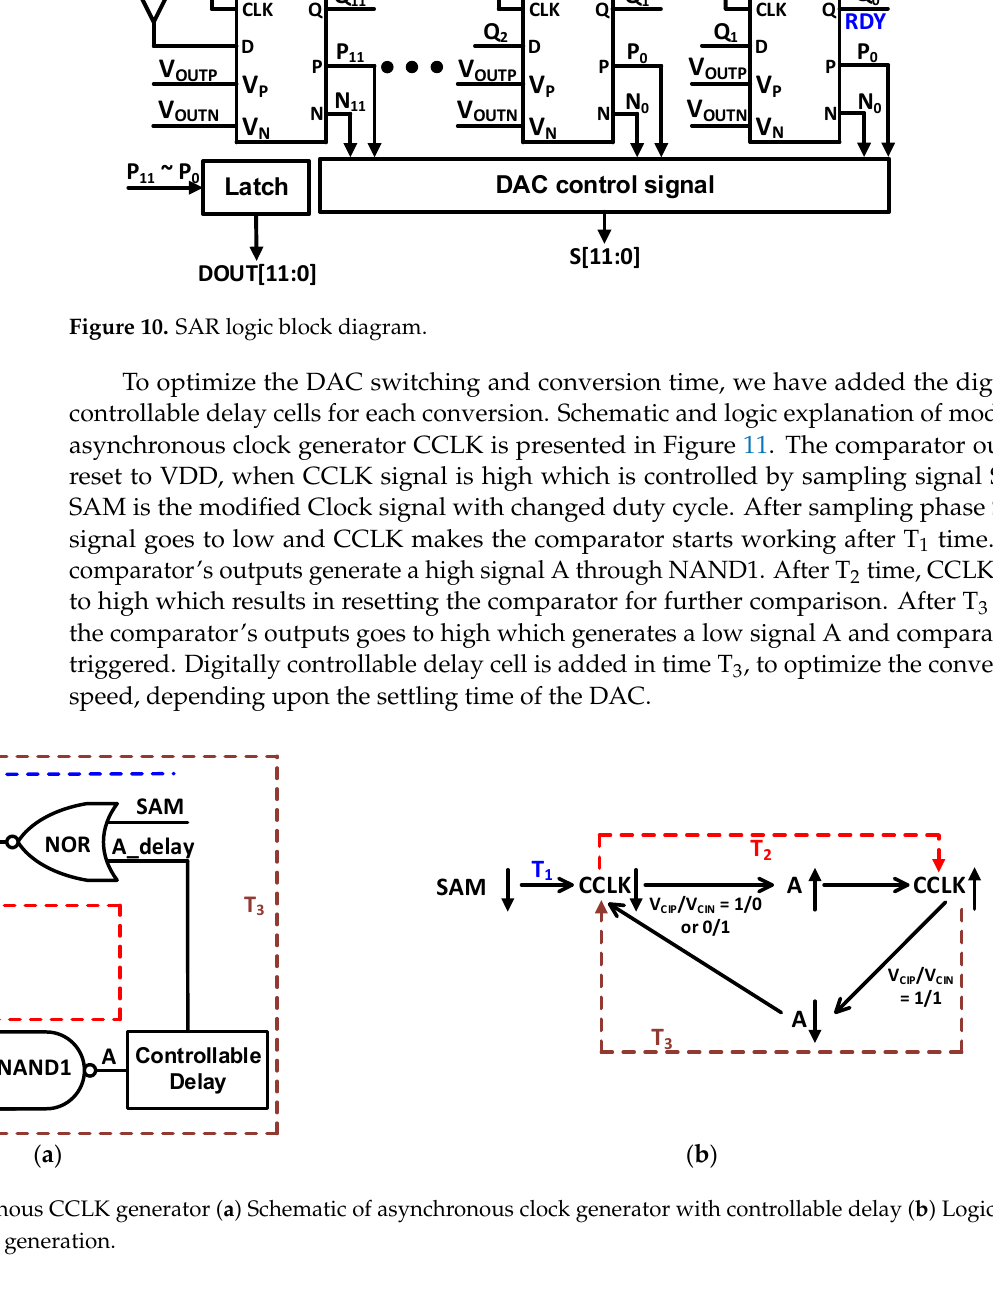
Figure 11. Asynchronous CCLK generator ( a ) Schematic of asynchronous clock generator with controllable delay ( b ) Logic description of CCLK generation.